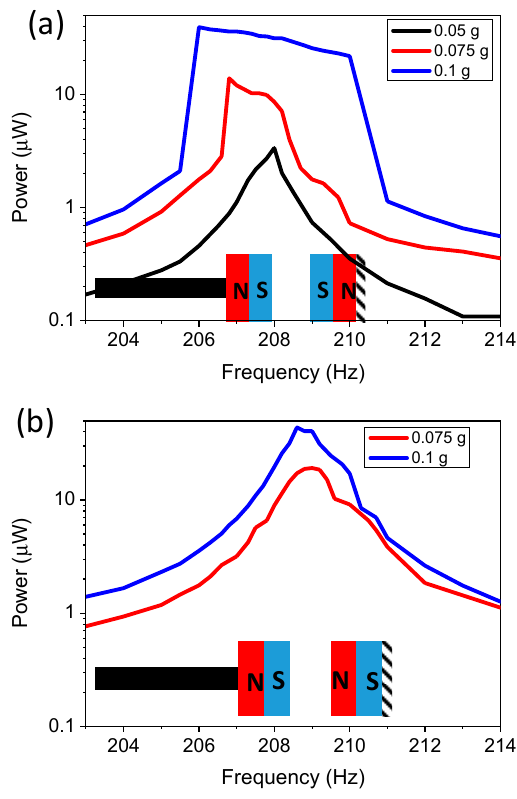
Figure 7. Experimental results of power as a function of frequency for an in-plane single-tether configuration for: ( a ) a repulsive magnetic configuration with varying acceleration; and ( b ) an attractive magnet configuration with varying acceleration.